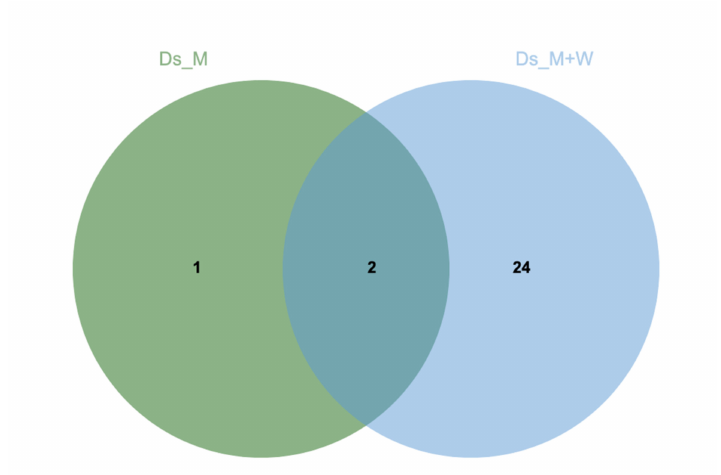
Figure 3. Venn diagram of D. seriata secreted proteins in malt medium (green) and in malt medium supplemented with grapevine sawdust (blue) adapted from [48]. Secreted proteins were extracted from three replicates.